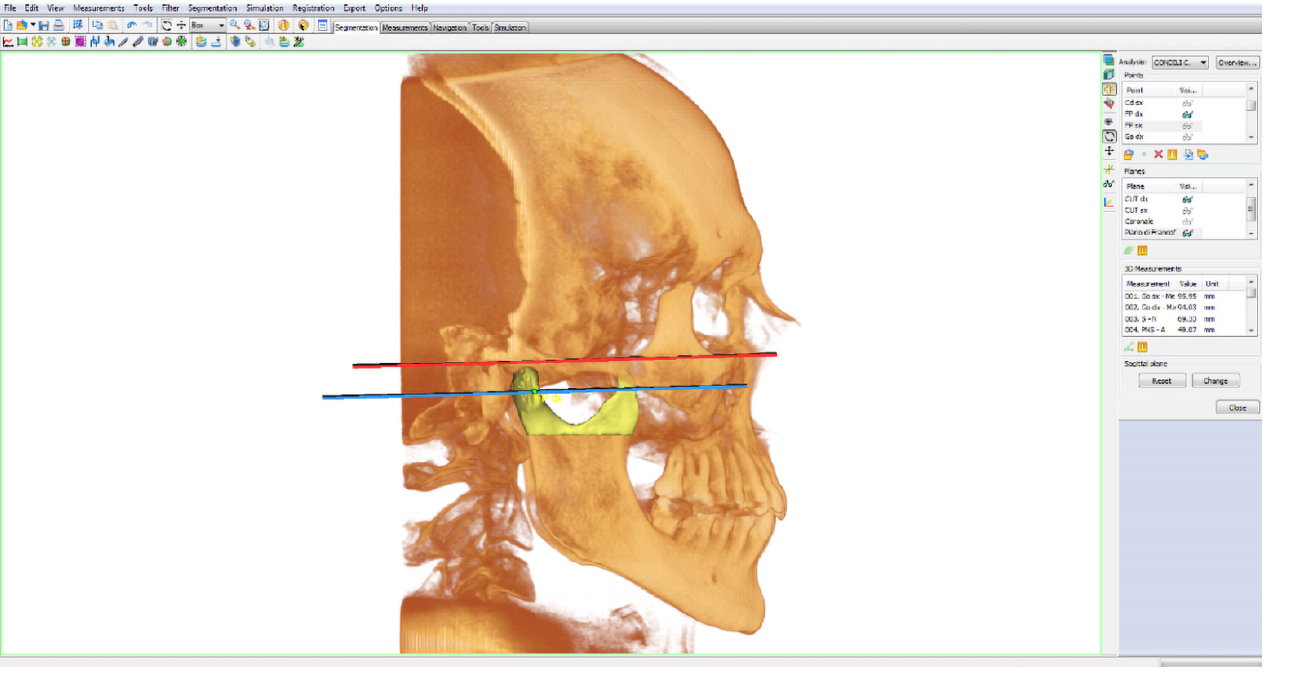
Figure 2. 3D rendering highlighting the Frankfurt plane (in red) and the cut plane of the right condyle (in blue) passing through the right pterygoid fovea point (right FP). Condyles were isolated before 3D measurements were performed, and the recom- mended range of bone density (226-3071 HU) was selected.